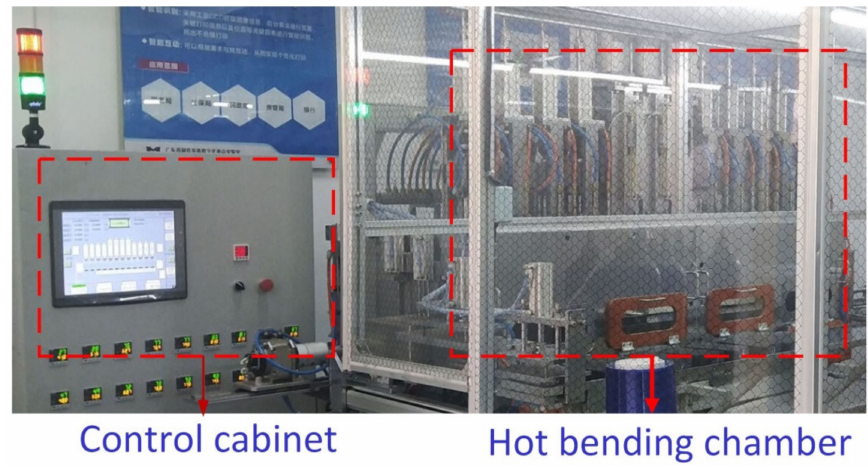
Figure 6. Intelligent fingerprint lock glass fingerprint touch plate bending machine.